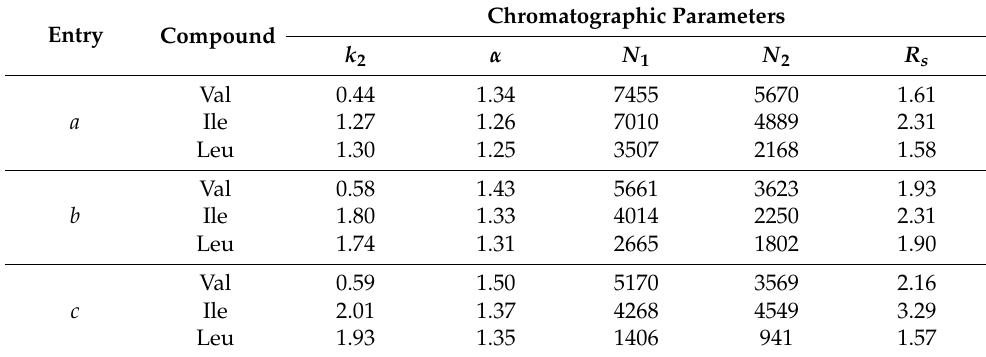
Table 3. Chromatographic performances obtained in the sole enantioselective LC system for the three BCAAs when varying the concentrations of the eluent additives. Mobile phase compositions are reported as footnotes to the table, while other experimental conditions are detailed in Section 2.3. The enantiomer elution order was the same in all of the analyses: D < L; k 2 is the retention factor of the second eluted enantiomer of each enantiomeric